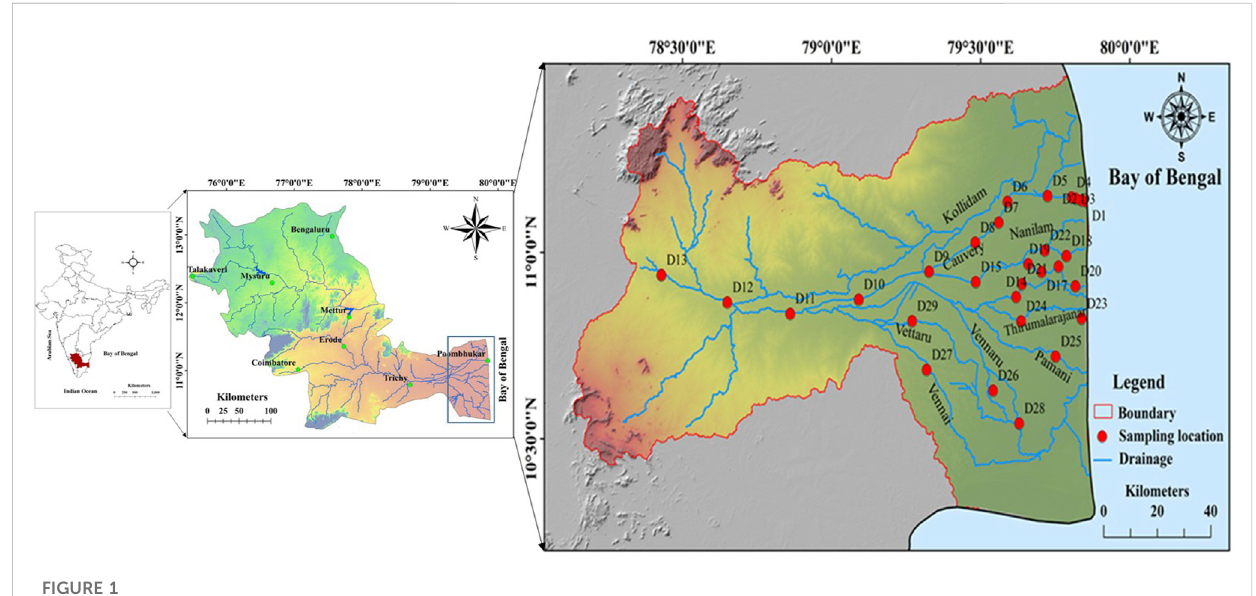
FIGURE 1 Study area with monitoring